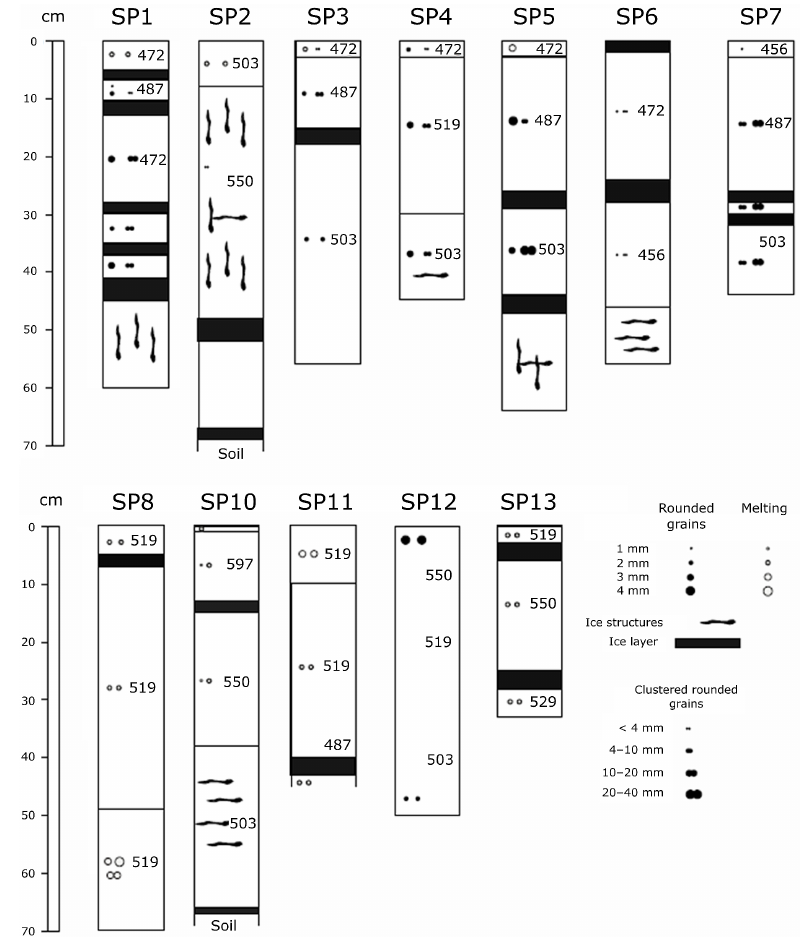
Figure 5. Snow pit description for the studied snow patches on Fildes